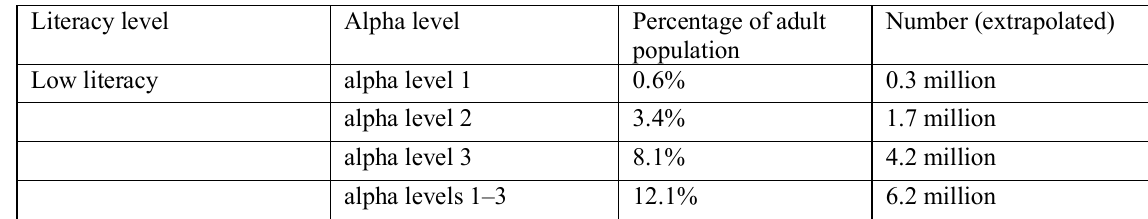
Table 1: German-speaking adult population (aged 18-64) classified by alpha level (2018) Literacy